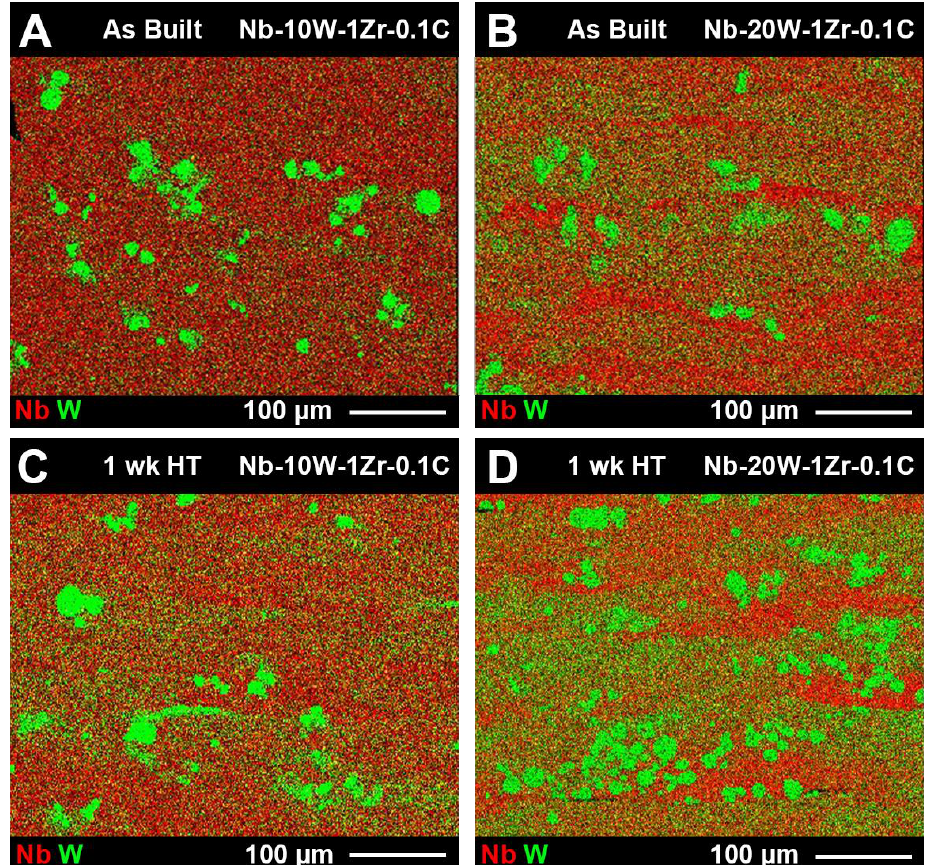
Figure 11. EDS RGB maps of ( A ) Nb-10W-1Zr-0.1C as-built, ( B ) Nb-20W-1Zr-0.1C as-built, ( C ) Nb-